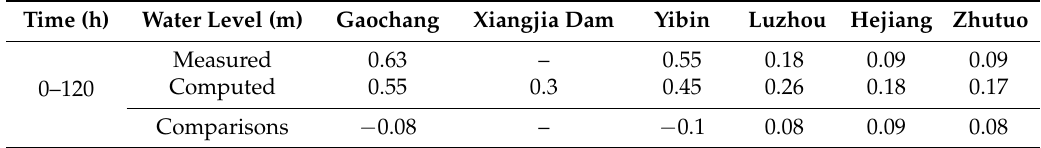
Table 1. Flood wave height and comparisons on 11–15 February 2013.